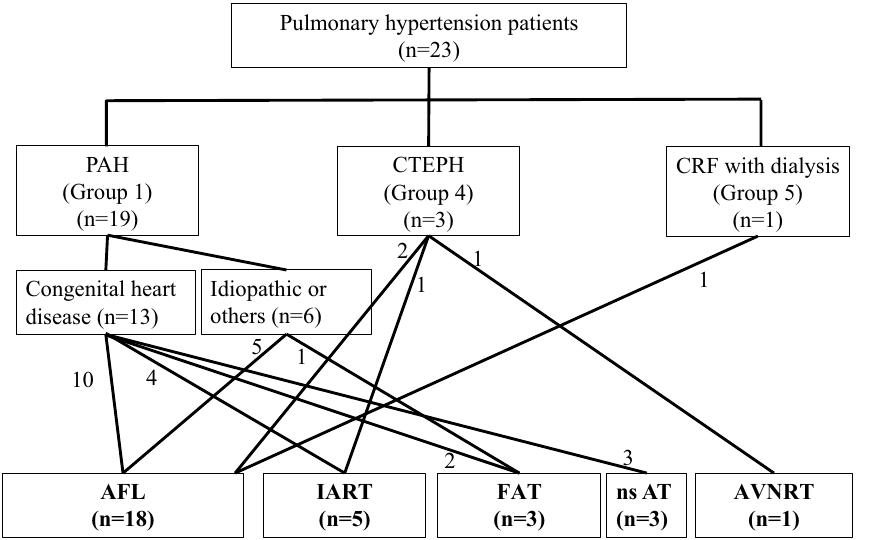
Figure 1. Study population and diagnosis. AFL: atrial flutter, AT: atrial tachycardia, AVNRT: atrioventricular nodal reentrant tachycardia, CRF: chronic renal failure, CTEPH: chronic thromboembolic pulmonary hypertension, FAT: focal atrial tachycardia, IART: intra-atrial reentrant tachycardia, ns: non-sustained, PAH: pulmonary arterial hypertension.